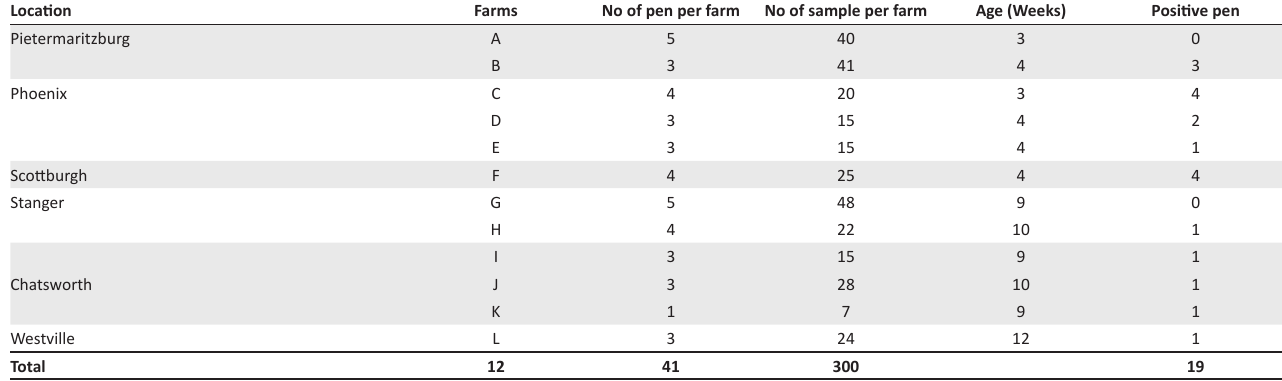
TABLE 1–A1: Summary of samples collected in broiler farms and the outcome of Eimeria detection. Location